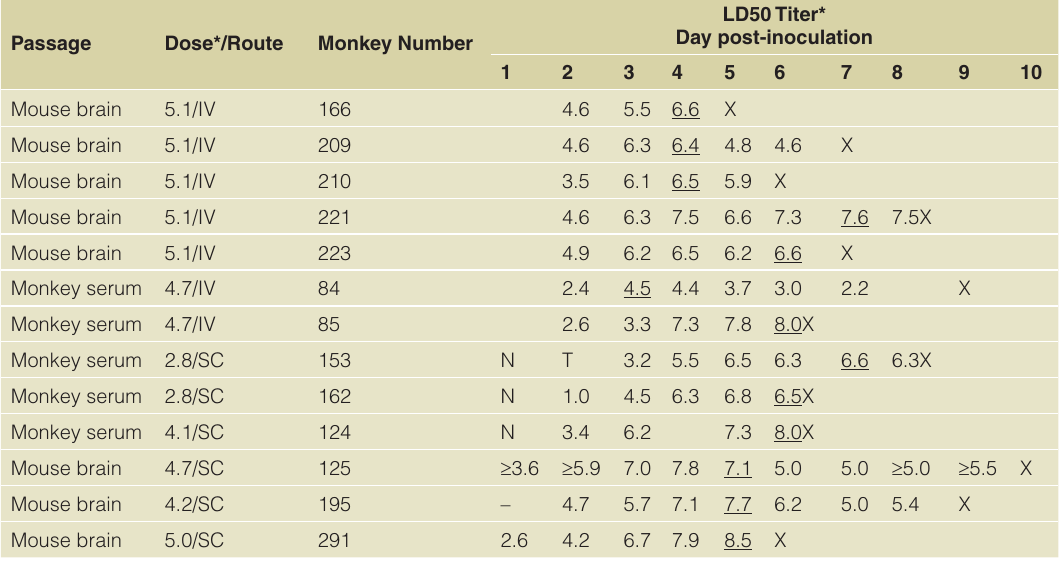
Table 1. Viremia and mortality in the black-faced langur after infection with virulent KFDV. * Positive logarithms of adult mouse LD50 titers/0.03 ml.